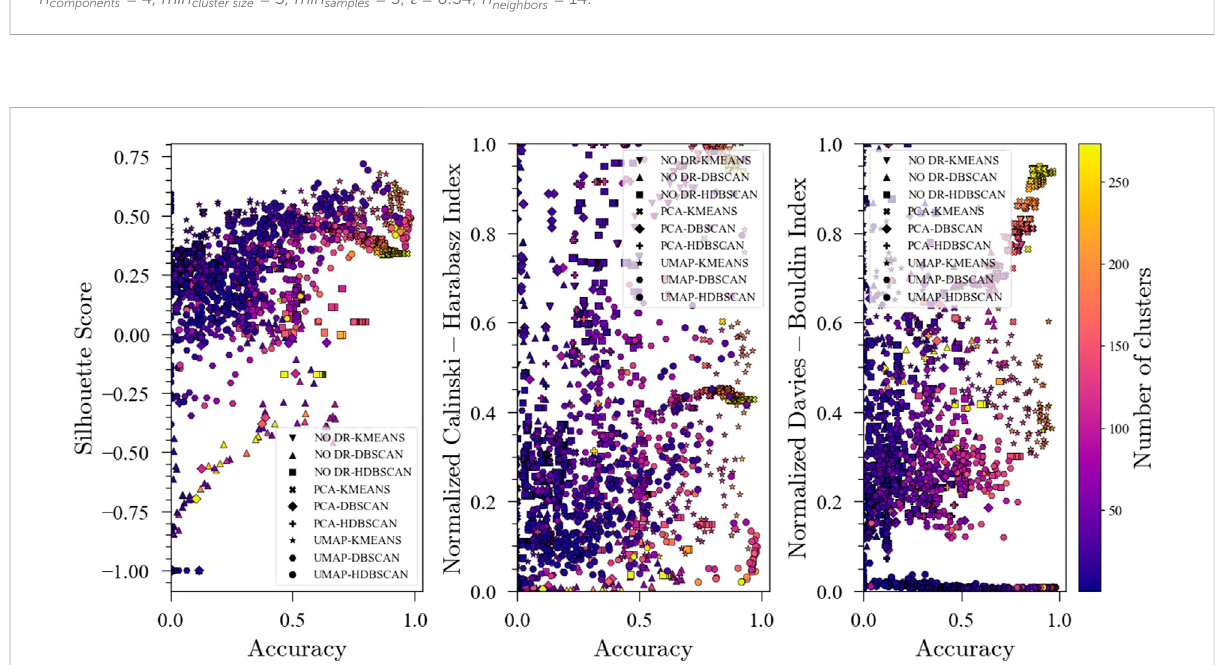
FIGURE 6 Evolution of the Silhouette Score, Davies-Bouldin Index and Calinski-Harabasz Index with accuracy during optimization for the Tennessee Eastman Process dataset with faults TEP01, TEP04, TEP07, TEP08, TEP10, and TEP13.